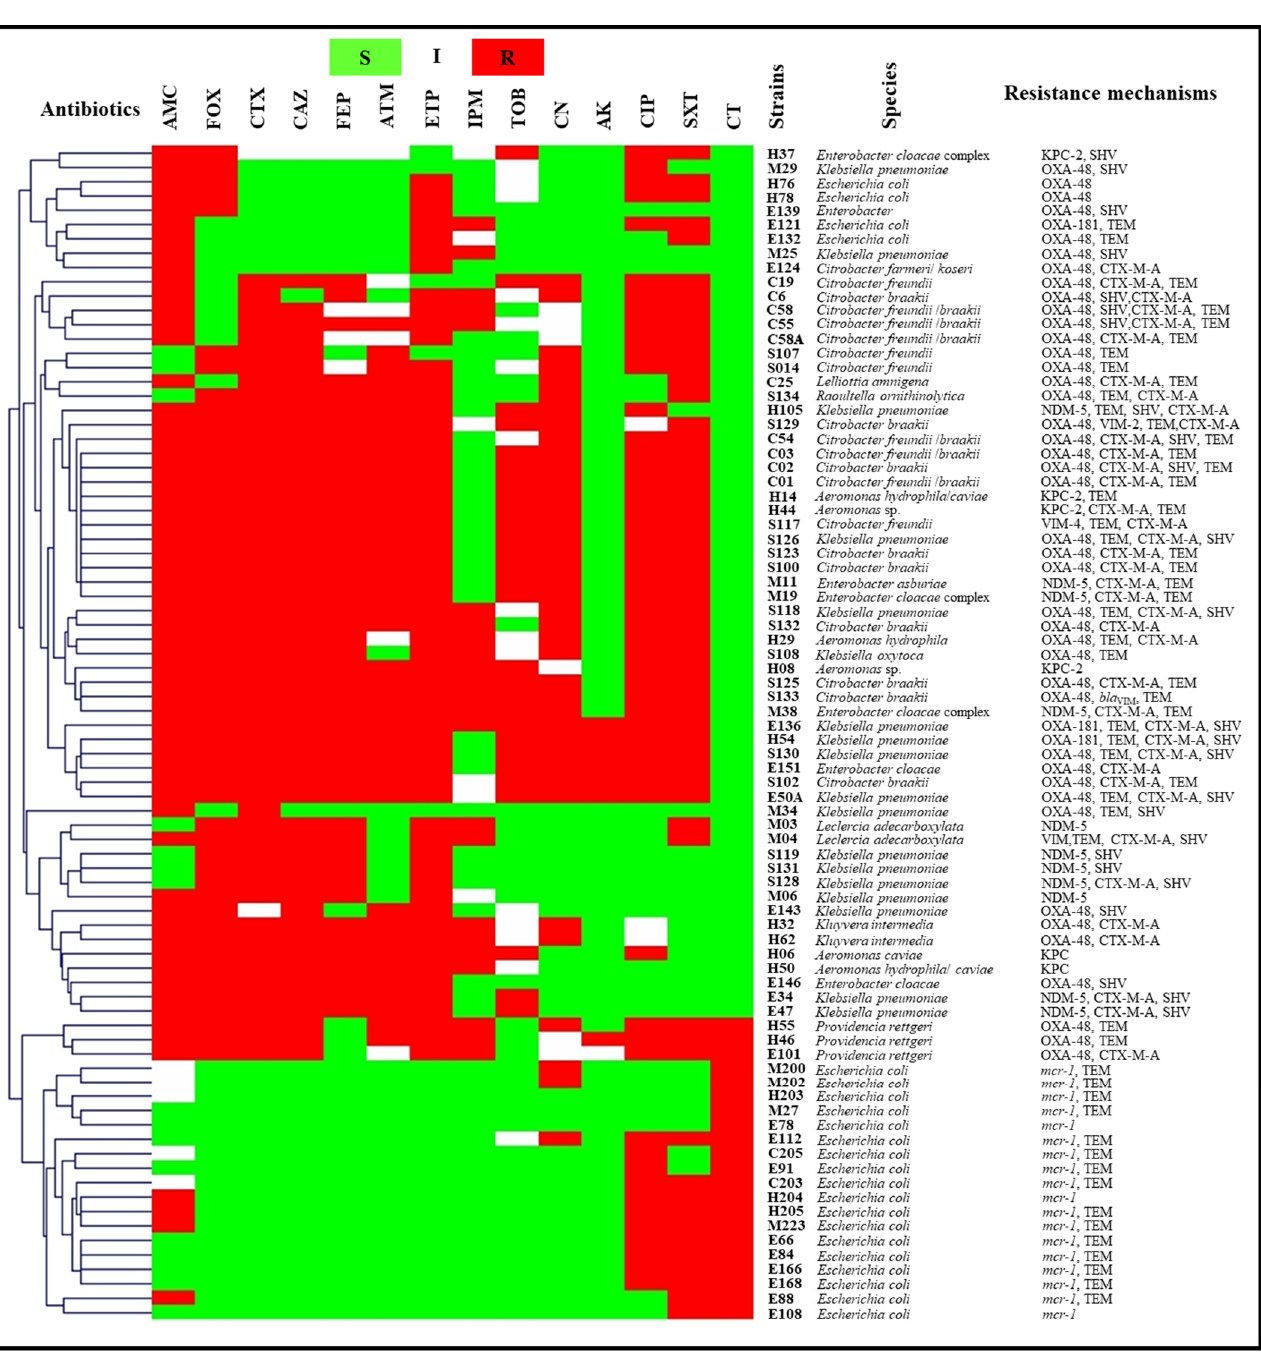
Figure 4. Antibiogram results and resistance mechanisms of enterobacteria and aeromonads isolates from wastewater clustered using the MultiExperimentViewer (MEV) software version 4_6_2. AK, amikacin; AMC, amoxicillin/clavulanate; ATM, aztreonam; CAZ, ceftazidime; CIP, ciprofloxacin; CN, gentamicin; CTX, cefotaxime; CT, colistin; ETP, ertapenem; FEP, cefepime; FOX, cefoxitin; I, intermediate; IPM, imipenem; PRL, piperacillin; R, resistant; S, susceptible; SXT, trimethoprim/ sulfamethoxazole; TIC, ticarcillin; TIM, ticarcillin/clavulanate; TOB, tobramycin; TPZ, piperacillin/tazobactam; Strains’ codes: C, cancer hospital; E, environment; H, university hospital; M, maternity hospital; S, public hospital.